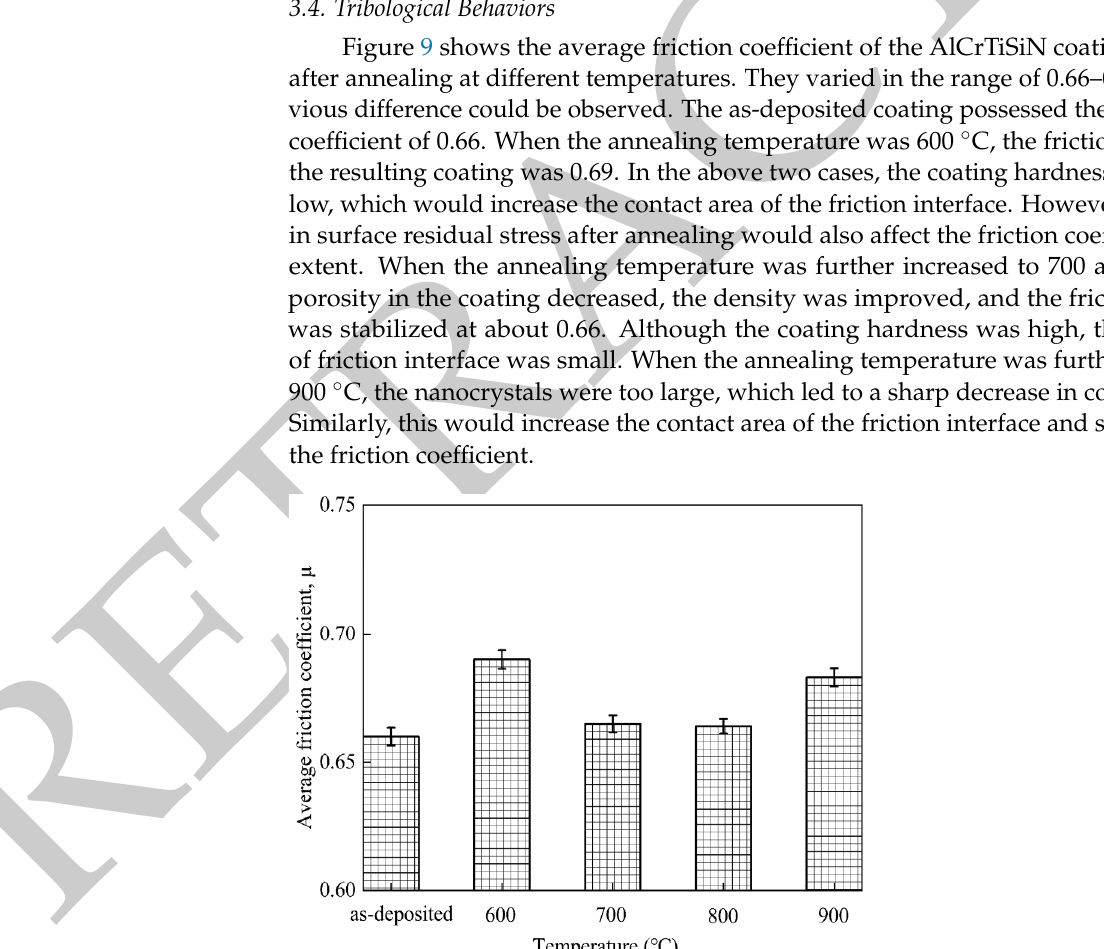
Figure 9. Friction coefficient of the AlCrTiSiN coatings before and after annealing at different tem- peratures.